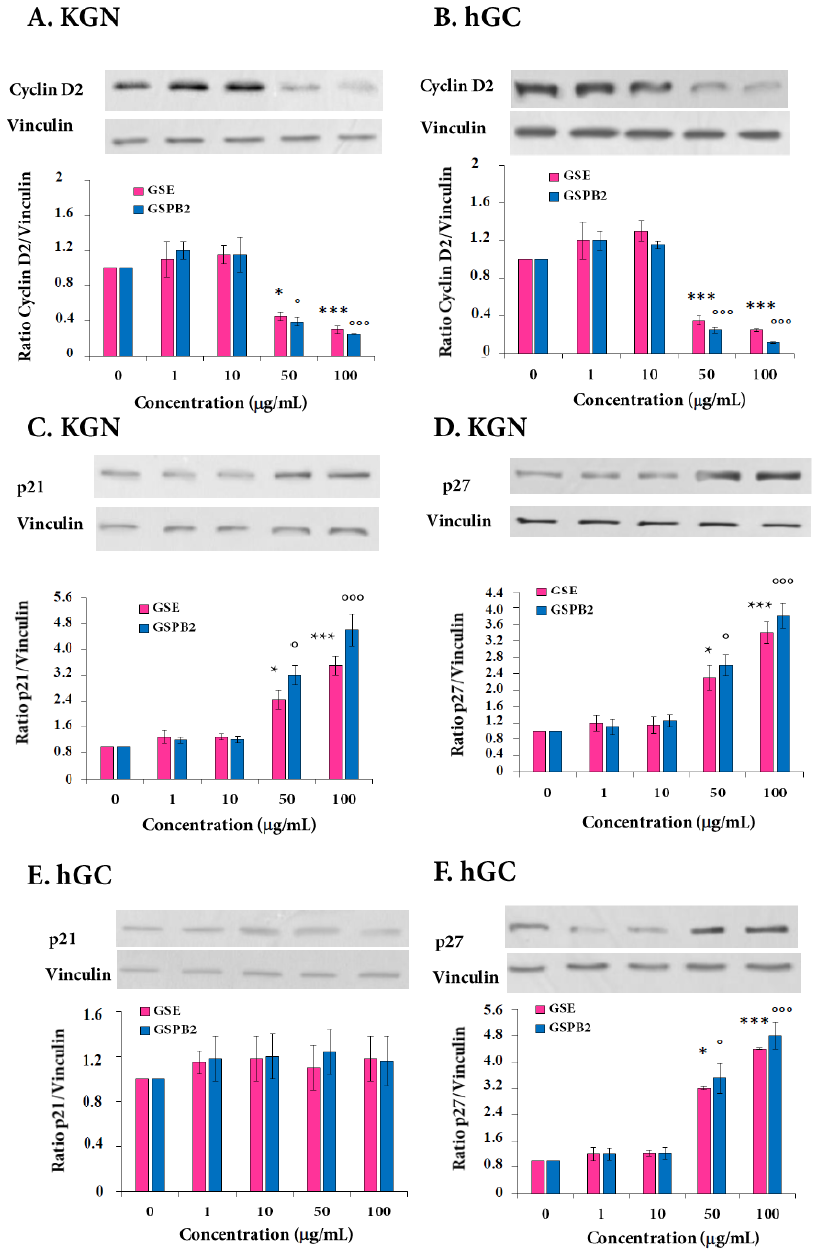
Figure 2. Effect of the GSE and GSPB2 treatments on the cyclin D2 ( A , B ), cyclin-dependent kinase inhibitors p21 ( C , D ) and p27 ( E , F ) protein levels in human granulosa cells. Human granulosa cells (KGN) ( A , C , D ) and hGC ( B , E , F ) were cultured in appropriate medium with 10% FBS and then supplemented for 24 h (cyclin D2, A , B ) and (CDKIs p21 and p27, C – F ) with different concentrations of GSE and GSPB2 (0, 1, 10, 50, and 100 µ g / mL). Cells were then harvested and cyclin D2, p21, and p27 protein levels were determined by immunoblot. Samples contained an equal amount of protein, as confirmed by reprobing each membrane with an anti-vinculin antibody. In each panel, immunoreactivity was quantified as described in Materials and Methods, and the ratio cyclin D2, CDKI p21 and p27 / vinculin were represented. Representative blots in response to different concentrations of GSE are shown. The results are means ± SEM of four independent cultures. For hGC cells, an independent culture was from a pool of cells collected from three patients. * and *** represent a significant effect of GSE as compared to the control at p ≤ 0.05 and p ≤ 0.001, respectively. ◦ and ◦◦◦ represent a significant effect of GSPB2 as compared to the control at p ≤ 0.05 and p ≤ 0.001,